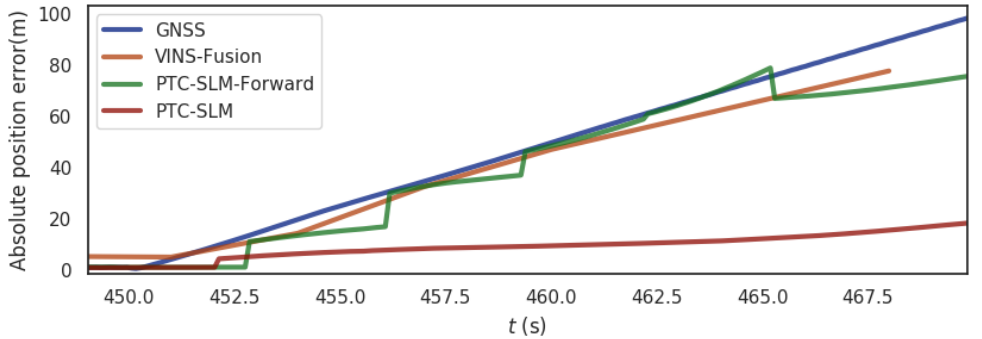
Figure 16. The absolute position error of the four methods in urban scene.